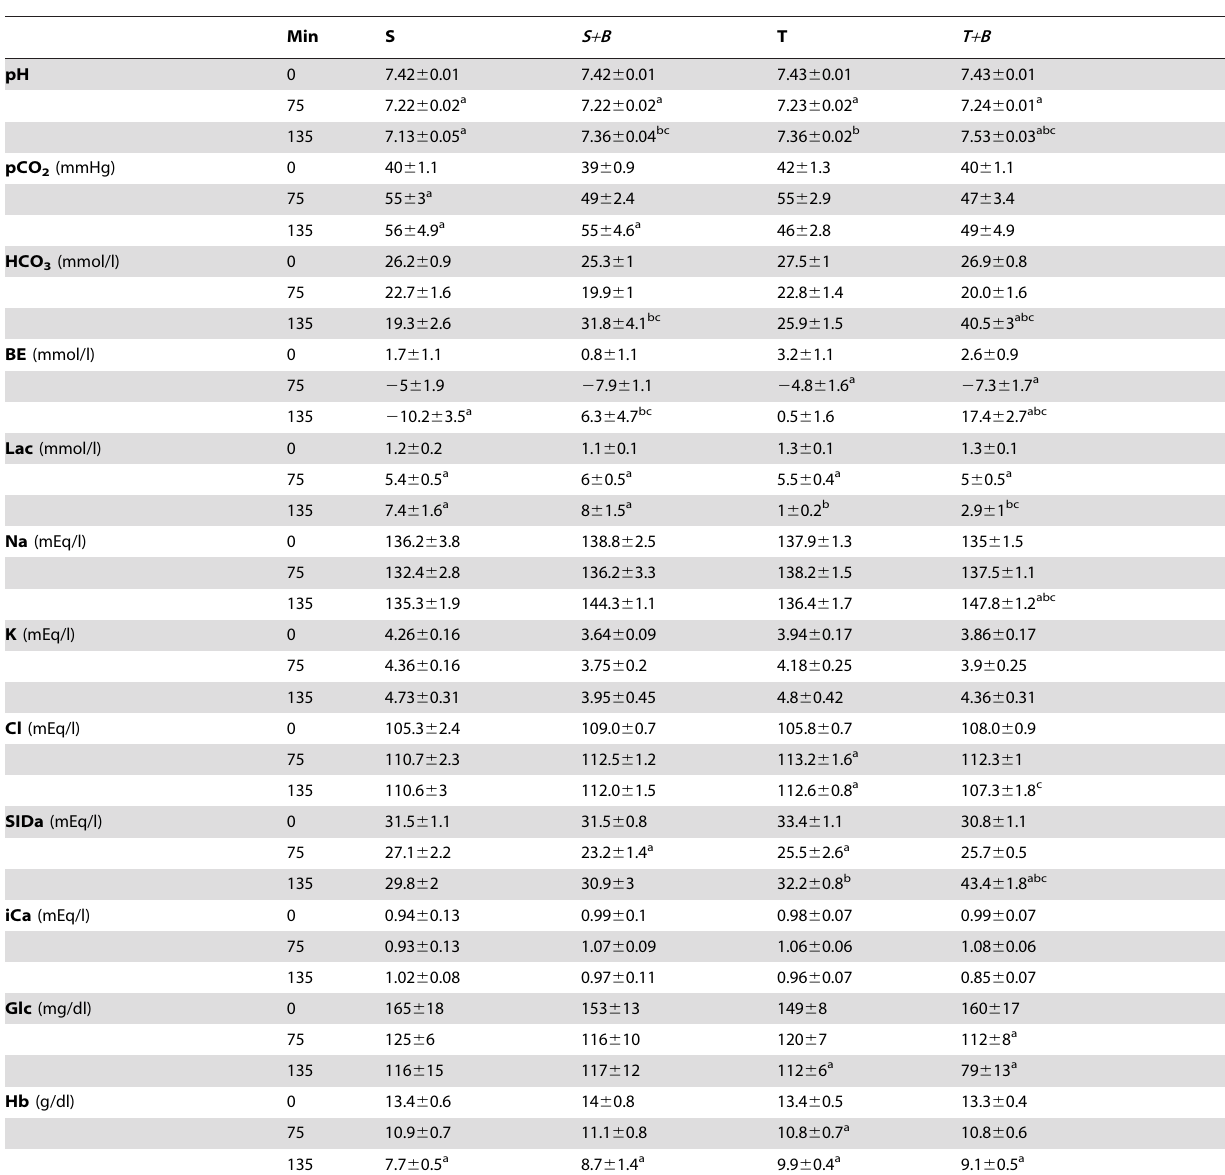
ANOVA P , 0.05: a vs. 0, b vs. 75, c S vs. S + B or T vs. T +